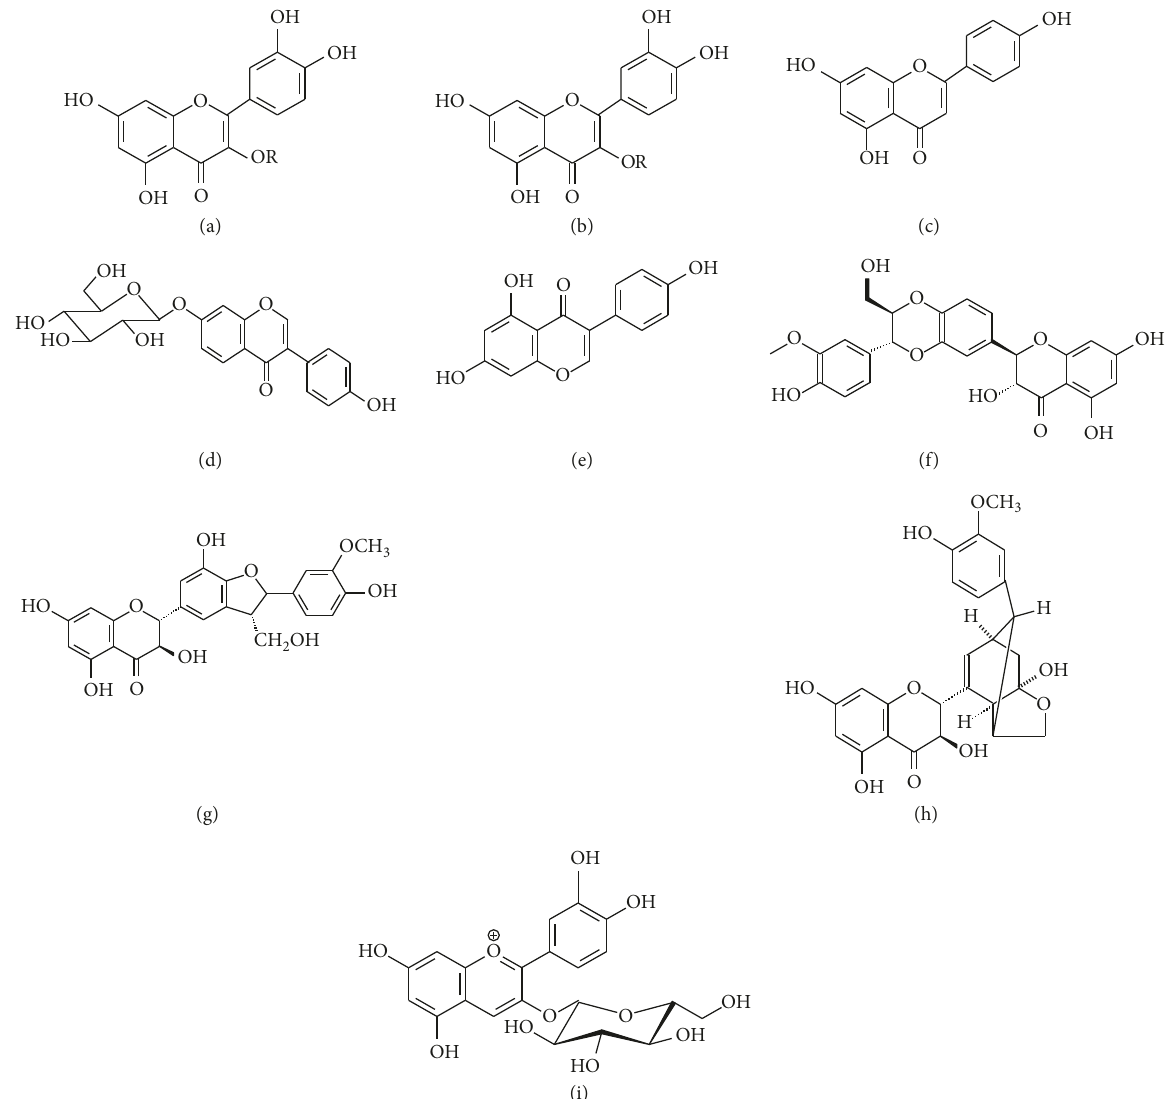
Figure 2: Some photoprotector flavonoids. (a) Quercetin, R � H. (b) Rutin, R � rutinose rutin. (c) Apigenin/cosmosiin. (d) Daidzein. (e) Genistein. (f) Silibinin. (g) Silychristin. (h) Sylidianin. (i)